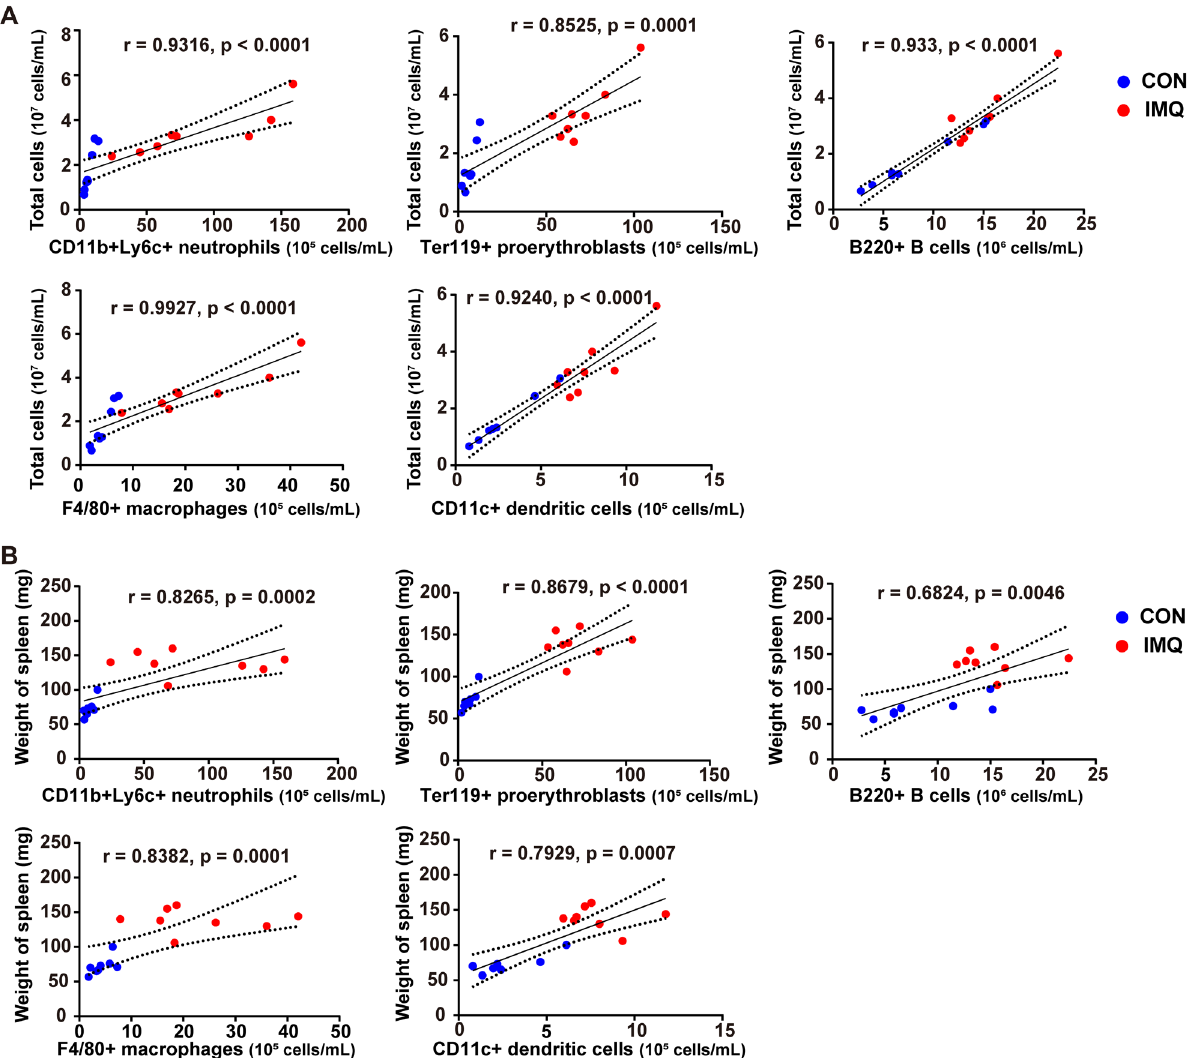
Figure 2. Correlations between the number of total splenic cells (or spleen weight) and the number of the splenic cell types. ( A ): The correlations between the number of total splenic cells and the number of the splenic cell types whose amount significantly increased in IMQ group. ( B ): The correlations between the weight of spleen and the number of the splenic cell types whose amount significantly increased in IMQ group. The values represent the mean ± SEM (n =